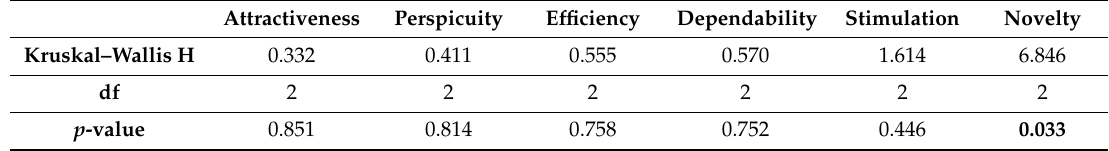
Figure 22. User experience results per category (attractiveness, perspicuity, efficiency, dependability, stimulation, and novelty) and per condition, in comparison with a benchmark dataset. In a further statistical analysis, a Kruskal–Wallis H test was utilized, in order to examine the existence of statistically significant differences in the six user experience categories, among the three